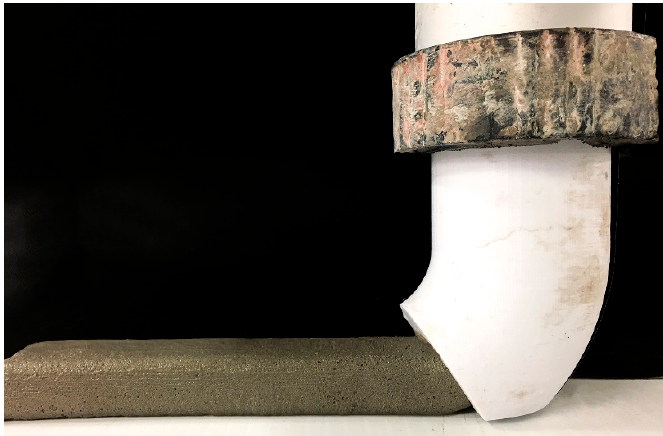
Figure 2. The geopolymer mortar being extruded from the nozzle.